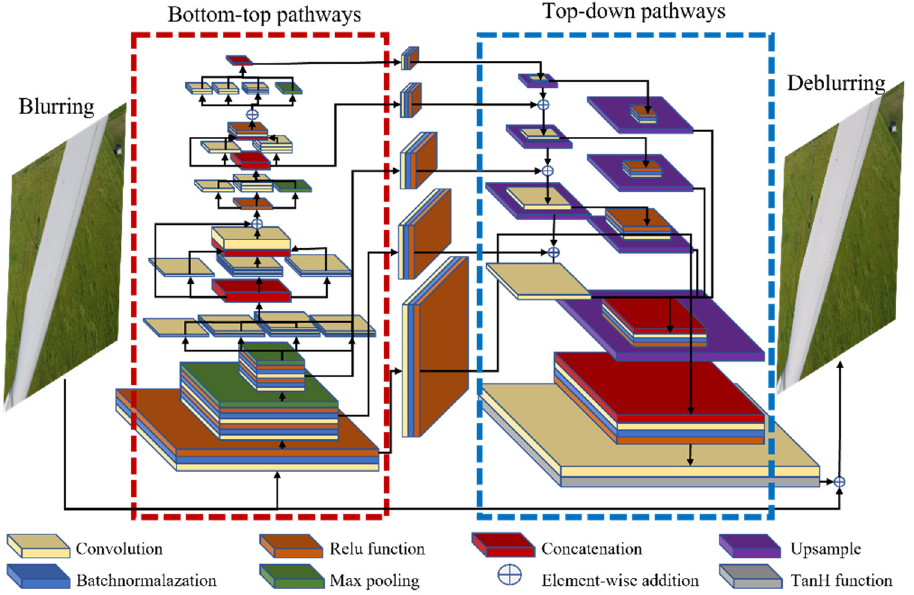
Figure 10. I-DeblurGANv2 generator structure.